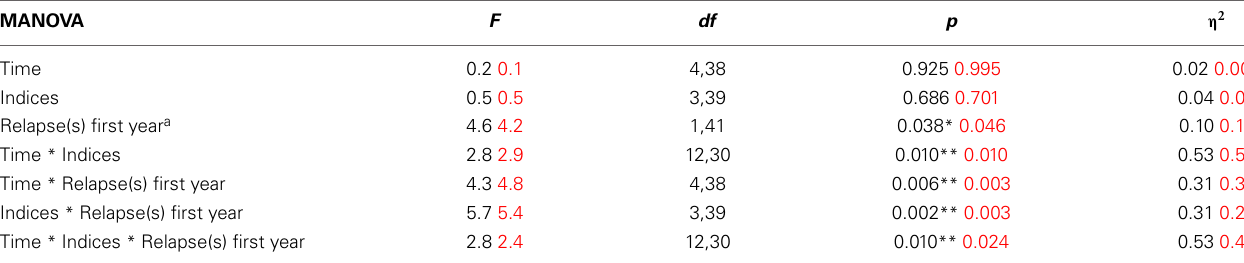
Table 3 | Results from MANOVA; effects of early relapse on neurocognitive indices over time (Corrected numbers in red).